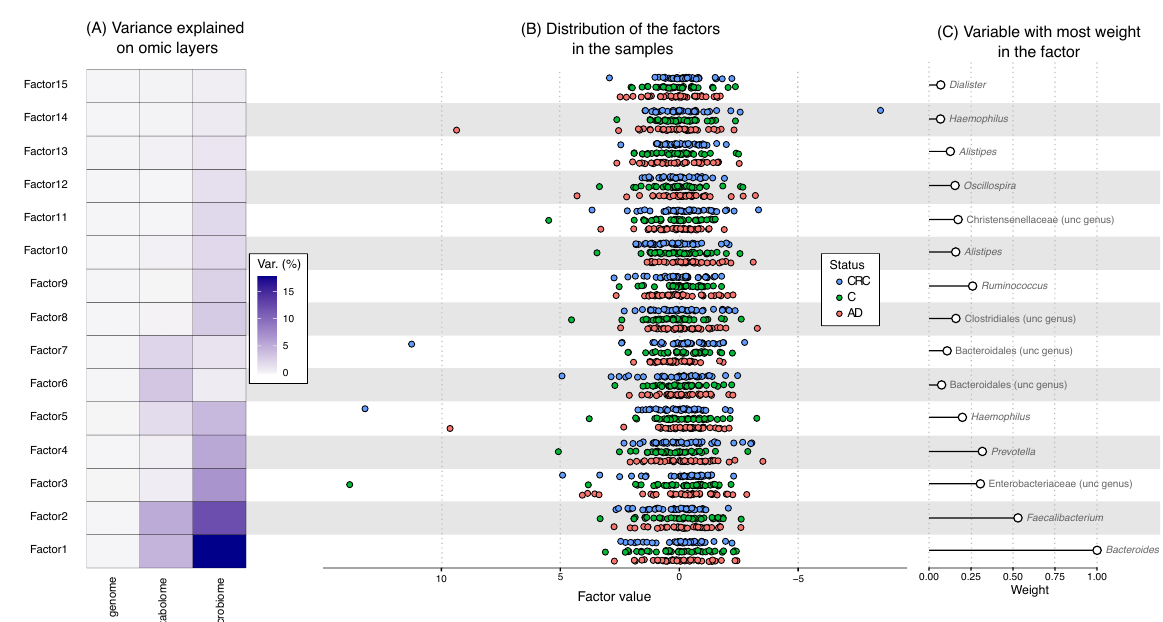
Figure 3. Factors derived from the integration of genome, metabolome and microbiome data. ( A ) The variance explained by each omic layer in each Factor. ( B ) the distribution of the values of the factors in each sample. CRC, colorectal cancer; C, healthy controls; AD, adenoma. ( C ) The variable with the most weight in the Factor. “Unc genus”, genus that was not classified, the identified lowest level is showed.